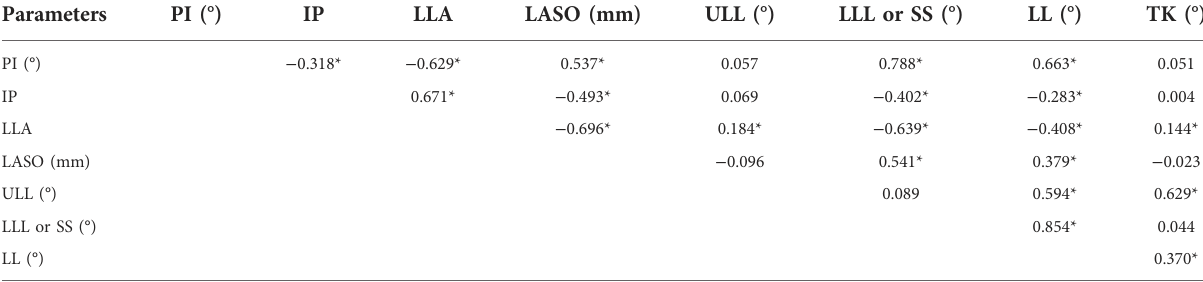
TABLE 4 Correlation coef fi cient of the spinopelvic parameters.